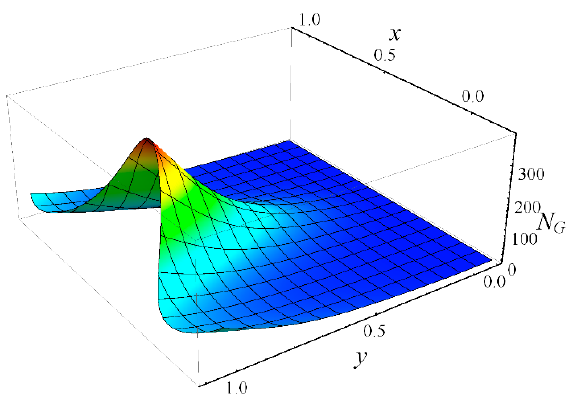
Figure 23. The total entropy generation number against variables x and y , when M = Br = 1, ε = 0.2, α = 0.1, ϕ = 0.01, β = 0.5, ξ = 0.05, η = 1.